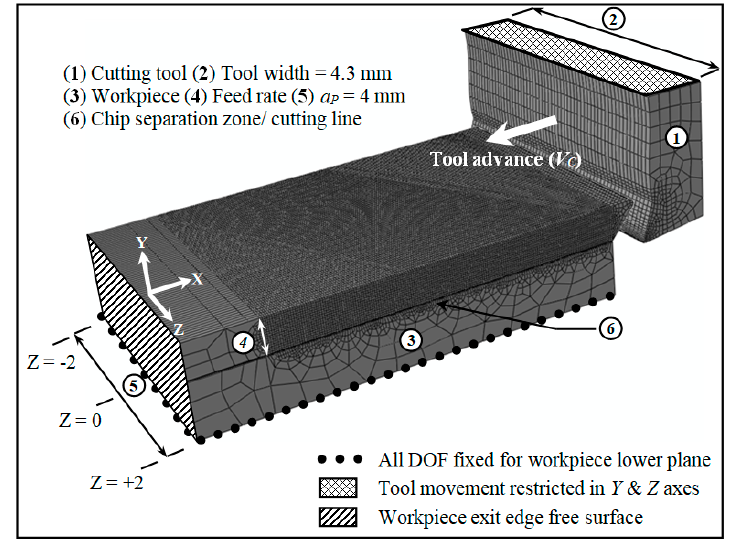
Figure 1. 3D geometrical model and boundary conditions for orthogonal